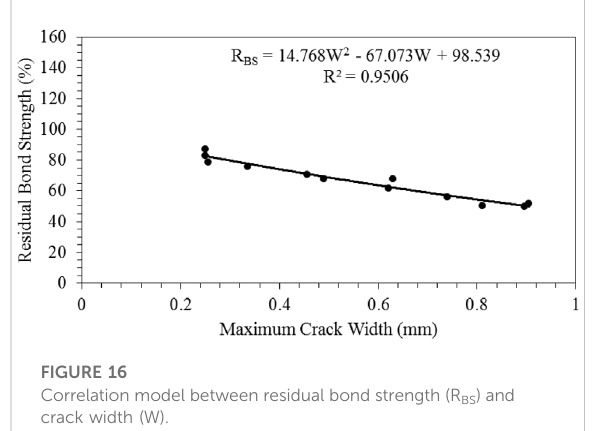
FIGURE 16 Correlation model between residual bond strength (R BS ) and crack width (W).